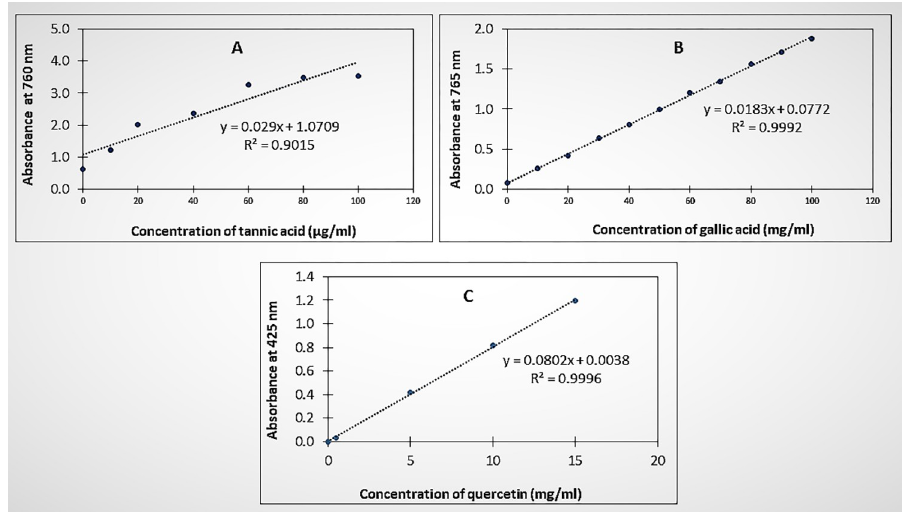
Fig 2. Standard calibration curves for the quantification of phytochemicals in N . sativa seeds extracts. (A): Calibration curve of tannic acid for the determination of total tannin content in aqueous and methanol extracts of N . sativa seeds. (B): Standard calibration curve of gallic acid for the determination of total phenolic content in aqueous and methanol extracts of N . sativa seeds. (C): Standard calibration curve of quercetin for the determination of total flavonoid content in aqueous and methanol extracts of N . sativa seeds.